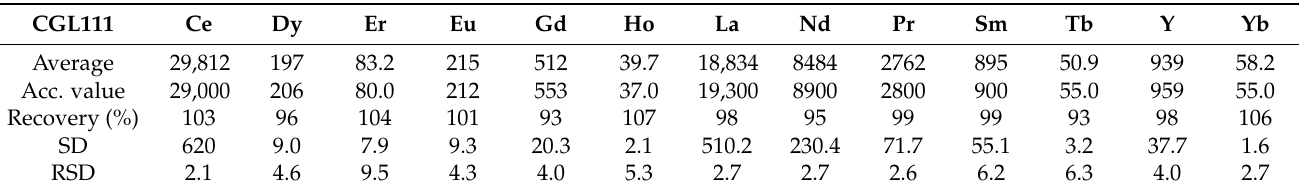
Performance of the developed method on CGL111 analysis in terms of accuracy and precision.